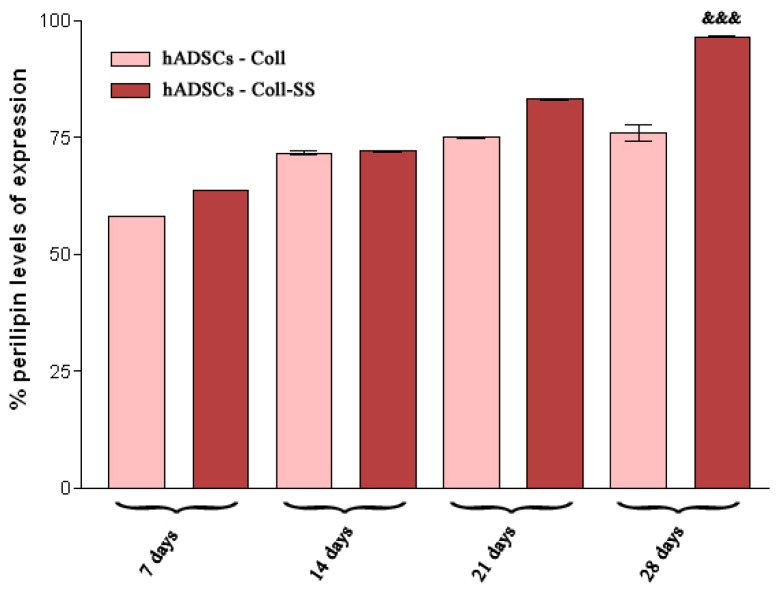
Perilipin expression in cells undergoing adipogenesis for up to 28 days in Coll vs. Coll-SS biomatrices, as revealed by flow cytometry [&&& p < 0.001 (Coll-SS bioconstruct vs. Coll bioconstruct: 28 days)].